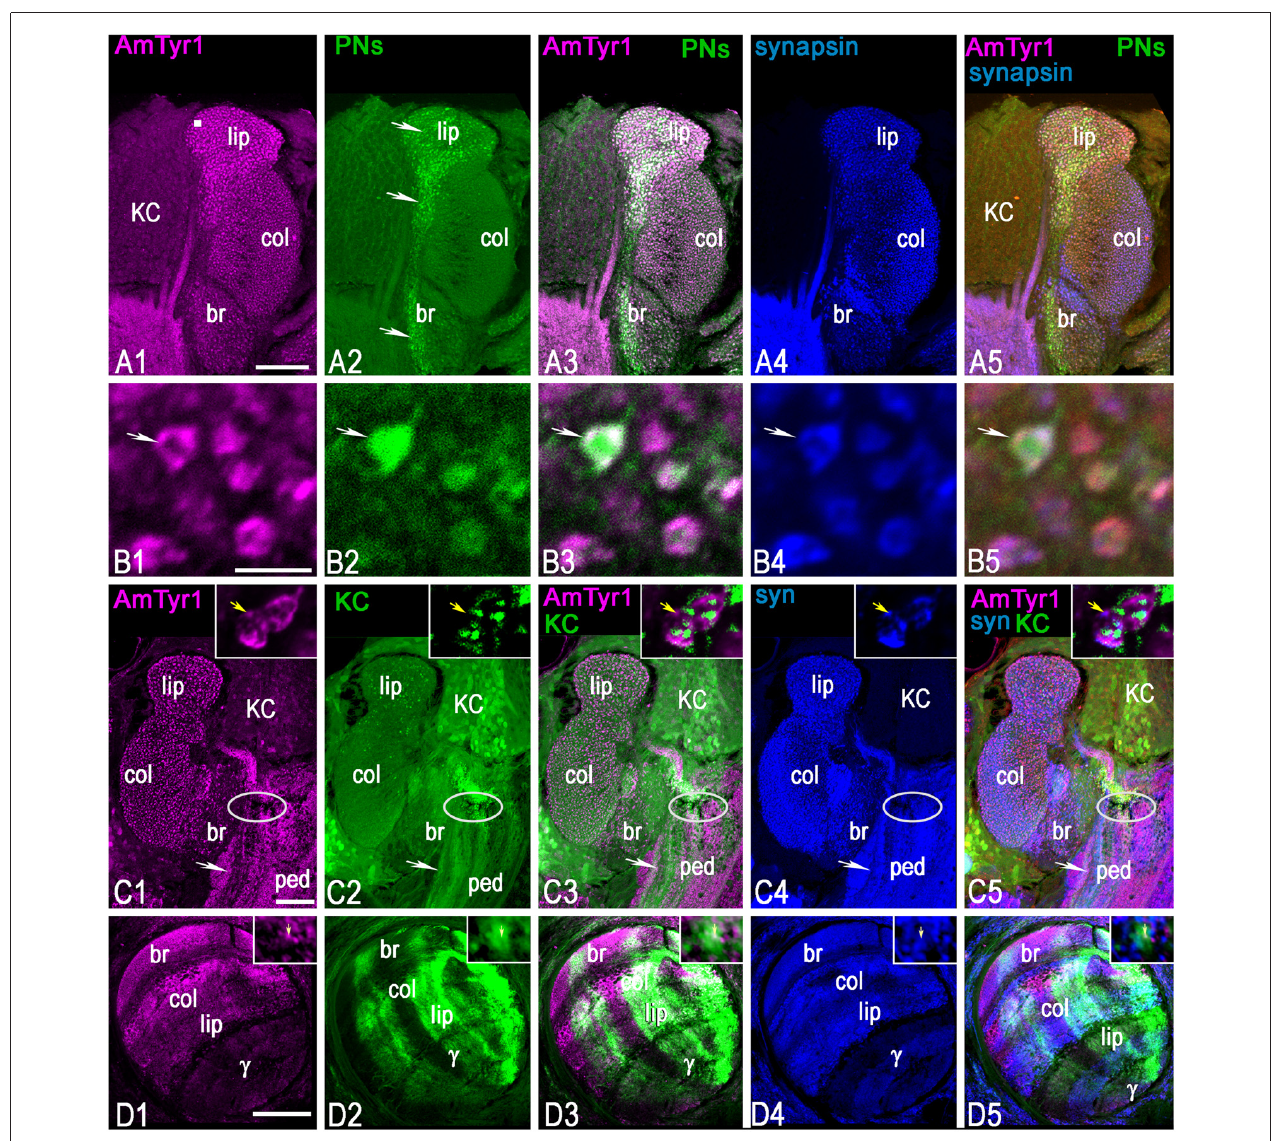
FIGURE 7 | Triple staining with anti-AmTyr1 (magenta) and anti-synapsin (blue) in the mushroom body after neurobiotin injection in uniglomerular projection neurons (uPNs; green, A,B ) and subsets of KCs (green, C,D ). (A) Anti-AmTyr1 antibodies (magenta, A1 ) co-label the neurobiotin injected uPNs ending in the calyx (green, A2 ). Arrows in (A2) show the axon from uPNs entering the basal ring and lip area of the calyx and labeling presynaptic parts of microglomeruli. Images in (B) illustrate at higher magnification microglomeruli indicated by the square in (A1) . Arrows in (B) show that single microglomeruli label with anti-AmTyr1 (magenta, B1 ) in a uPN terminal bouton (B2) . The white staining in merged images (A3,B3) indicates co-labeling of anti-AmTyr1 with uPN terminal microglomeruli. The microglomeruli labeled with anti-synapsin as a presynaptic marker ( A4,B4 , blue). The white staining in merged triple staining image (A5,B5) indicates that anti-AmTyr1 and anti-synapsin are co-labeled in uPN microglomeruli. (C,D) Anti-AmTyr1 labeled microglomeruli (magenta, C1 , insert in C1 ) in the calyx, subsets of KC bodies, the pedunculus (ped, C1 ). Also, areas of the mushroom body vertical lobe that correspond to KCs with dendrites in the basal ring, lip and collar areas of the calyx have a high level of staining intensity (D1) . The (KCs) were injected with neurobiotin in the area indicated in (C) by an ellipse, and in single image staining (green, in C2,D2 ) the neurobiotin revealed in cell bodies, dendrite in calyx ( C2 , insert in C2 ) and in lobe (D2) . Only subsets of KCs took up the neurobiotin in this preparation. For the injection of neurobiotin in the area shown by the ellipse in (C) , the subsets of KCs that took up the tracer express it in cell bodies, in dendrites in the lip, basal ring and collar ( C2 , insert in C2 ), and in the axons of the corresponding area of vertical and gamma lobe (D2) . Merged images (C3,D3) show the co-localization of KCs that take up neurobiotin with AmTyr1 in axons but not in the dendrites of the calyx (inserts in C3 ). (C) AmTyr1 (magenta C1 ) expression in subsets of mushroom body KC axons (green, C2 ) but not in the dendrites in the calyx (insert in C ). The merged images in (C5) illustrate co-localization of anti-AmTyr1 with anti-synapsin (blue, C4 single staining) in calyx microglomeruli, but not with neurobiotin labeled KC dendrites in calyx (insert in C4 , C5 respectively). Anti-AmTyr1 in the mushroom body lobe is in KC axons; these KCs have dendrites in the basal ring and collar areas. In insert (D1) -AmTyr1 (magenta) is in axons of KC labeled with neurobiotin ( D2 , single image) and co-labeled with synapsin in ( D4 ; single image). In the triple staining image ( D5 ; insert D5 ) the white color corresponds to co-labeling of synapsin in KC axons and AmTyr1. Note, that not all synapsin labeling processes (single staining image D4 , insert D4 ) express AmTyr1 (single staining image D1 , insert D1 ). Arrows in insert (D1–D5) shows AmTyr1 in the axon of KC co-labeled with synapsin. Scale bar: A,C,D = 50 µ m, B = 2 µ m.